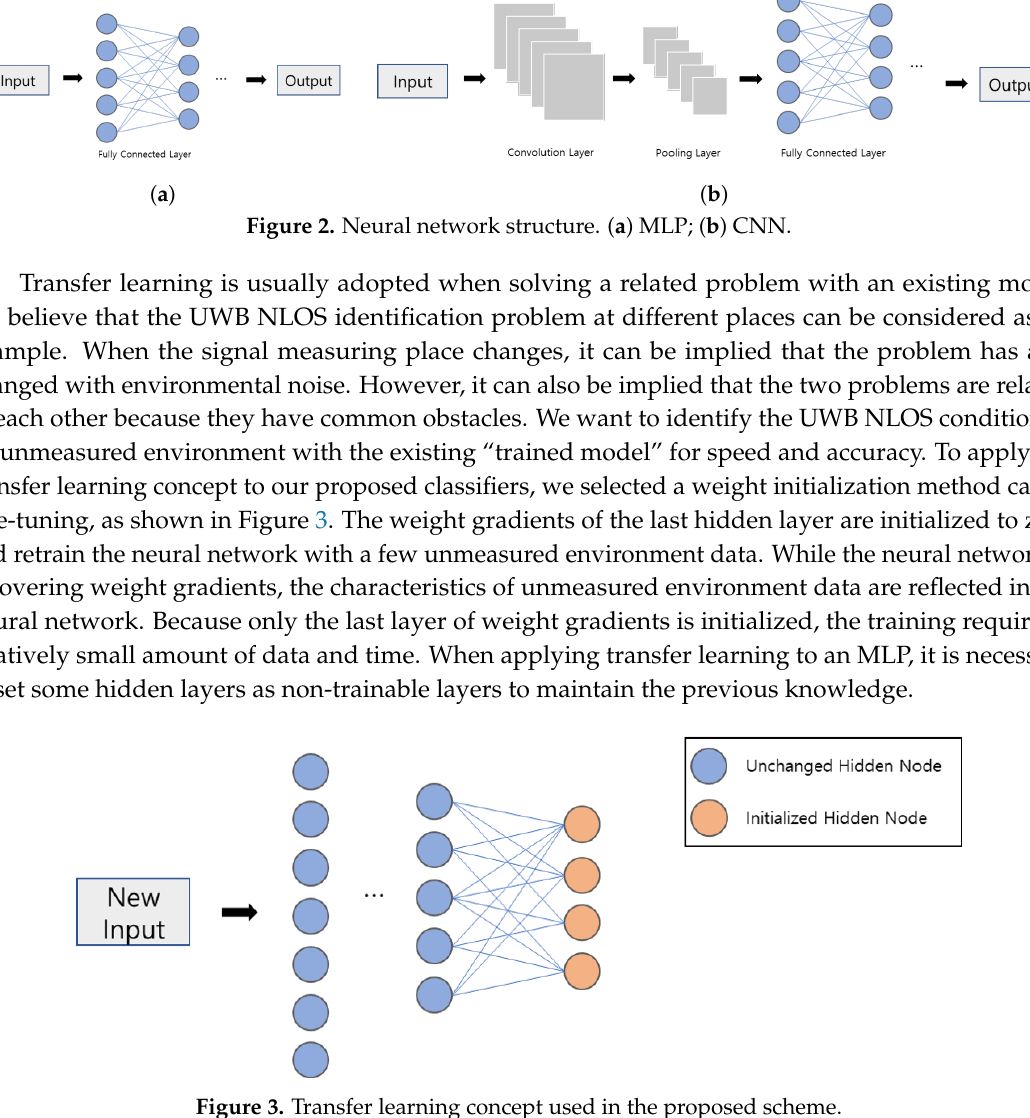
Figure 3. Transfer learning concept used in the proposed